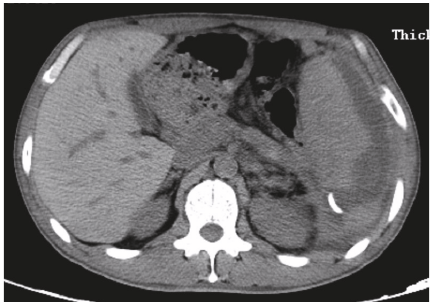
Figure 7: About 2 weeks after splenic artery embolization and ultrasound-guided percutaneous drainage of pancreatic pseudocyst, CT showing the disappearance of pancreatic pseudocyst, multiple areas of infarction on the spleen, and the significant reduction of splenic subcapsular hematoma.